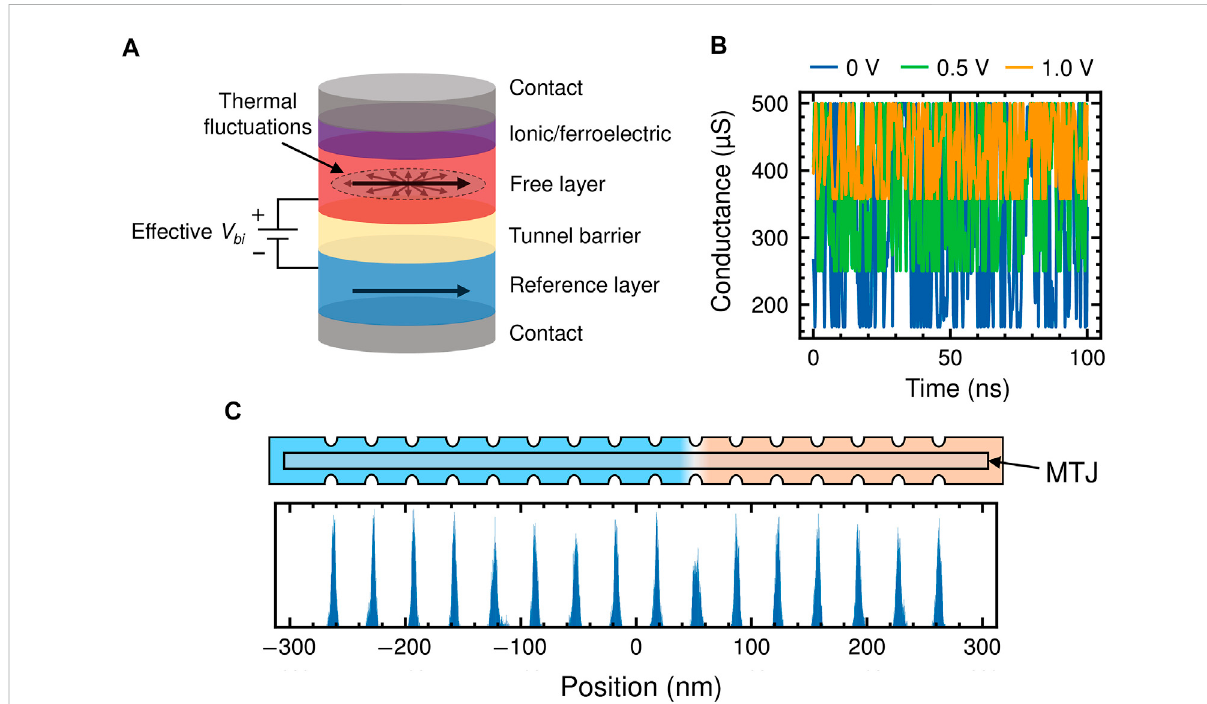
FIGURE 1 (A) Structure of the Bayes-MTJ. Thermal fl uctuations cause random changes in the in-plane magnetization of the free layer that manifest as noise in the tunnel magnetoresistance, (B) Simulated noise in the Bayes-MTJ conductance. The applied voltage modulates the TMR and the magnitude of the noise via the VCMA effect. (C) Structure of a notched DW-MTJ synapse. Bottom shows the distribution of DW position over 25 ns after being initialized in each of 16